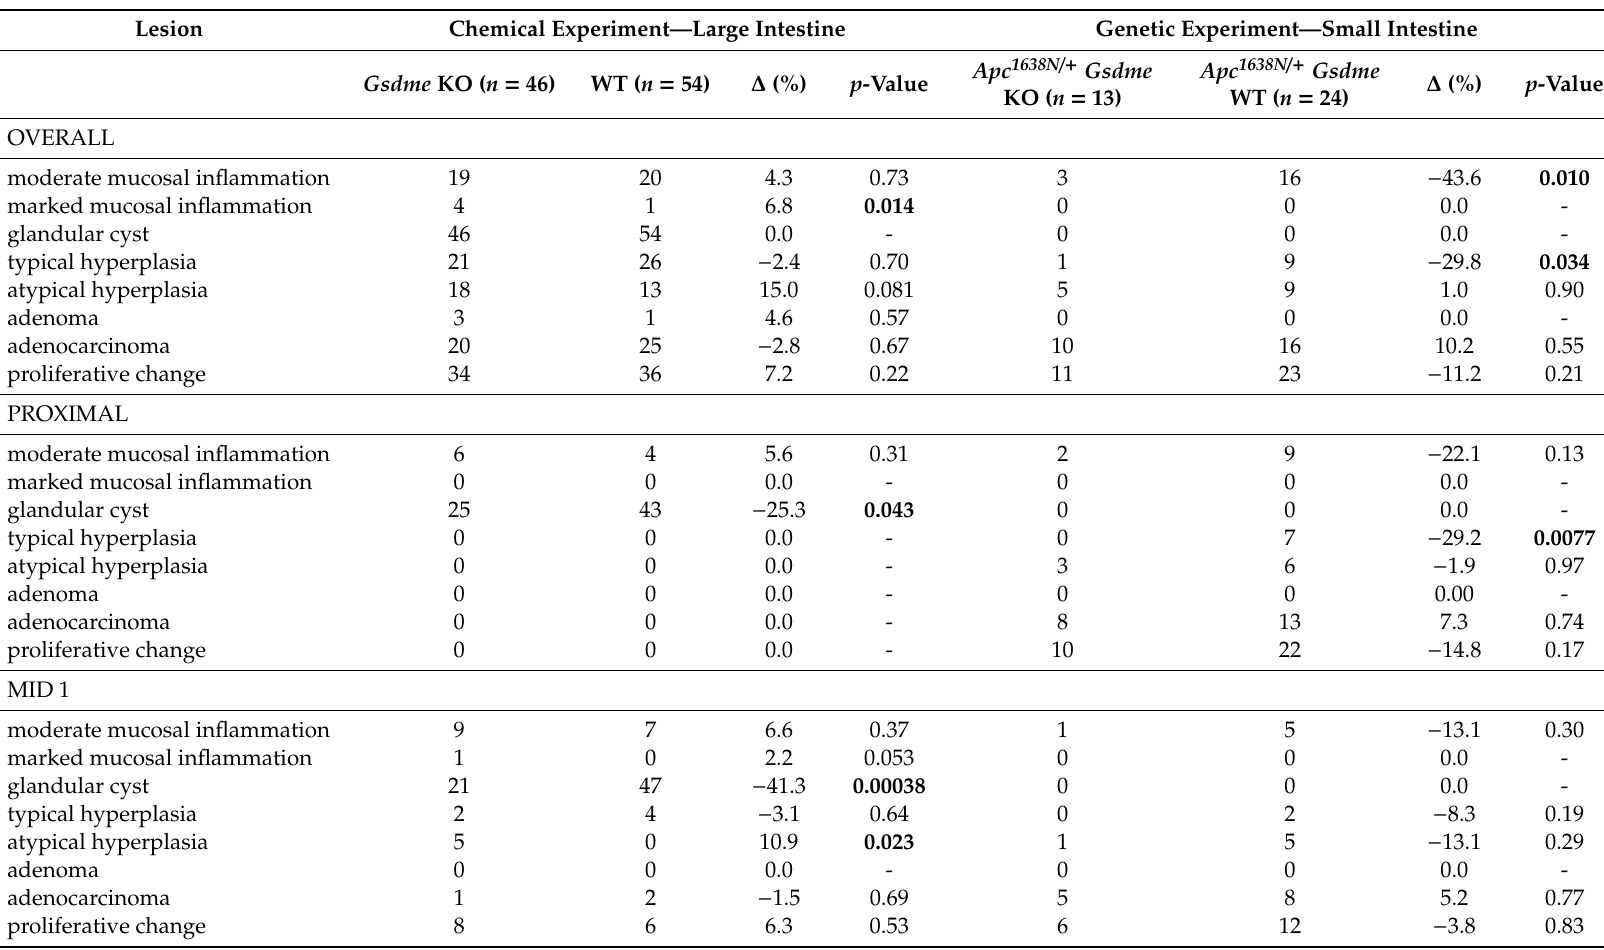
Table 1. Overview of all lesions scored in the large intestine of AOM-treated mice (all timepoints combined) and in the small intestine of Apc 1638N /+